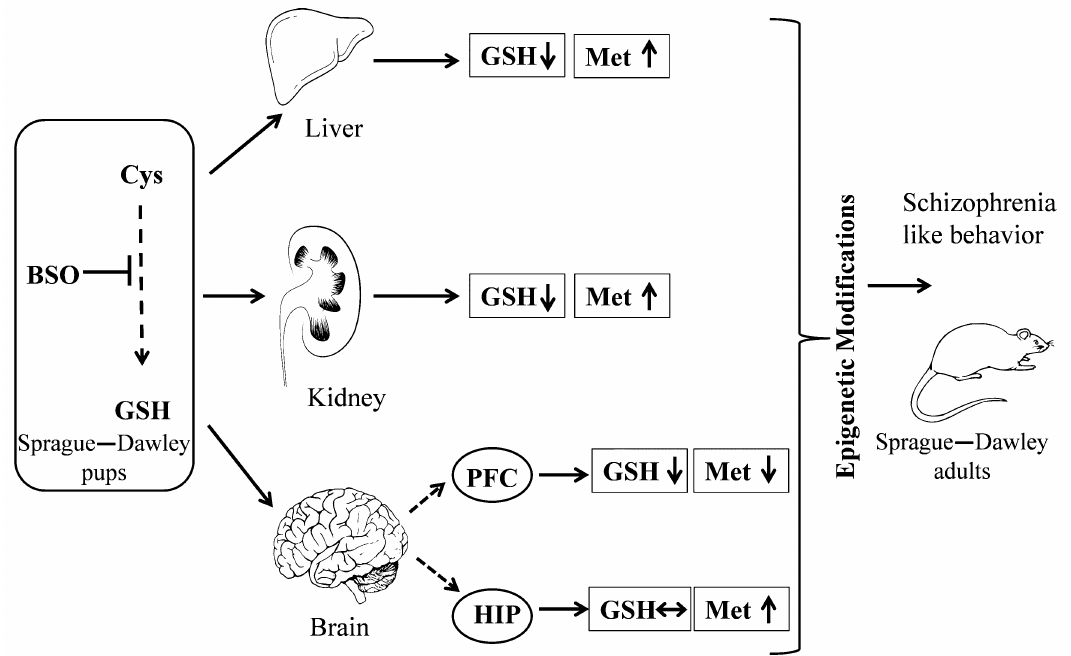
Figure 11. Graphic illustration of the experimental procedure and e ff ects of chronic BSO administration at postnatal days 5–16 on the levels of GSH and Met in 16-day-old rats and on the epigenetic status in the PFC and HIP in adulthood. Arrows indicate: ↑ —increase; ↓ —decrease; and ↔ —no changes .